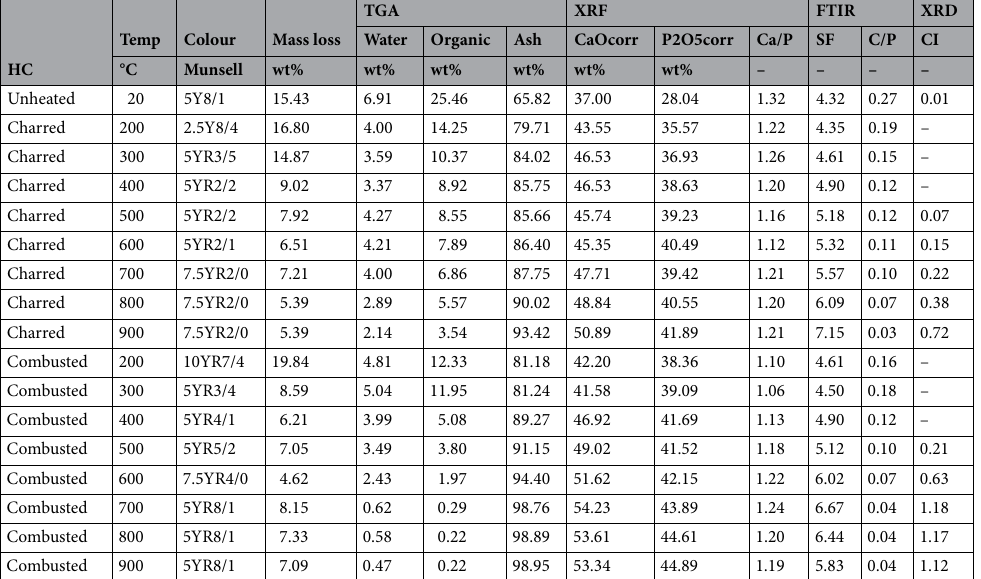
Table 2. Overview table showing the numeric results for the samples exposed to pH 3 conditions, per analytical technique. For the XRF results the TGA-corrected values are displayed. A dash (–) indicates that particular samples were not analysed for that